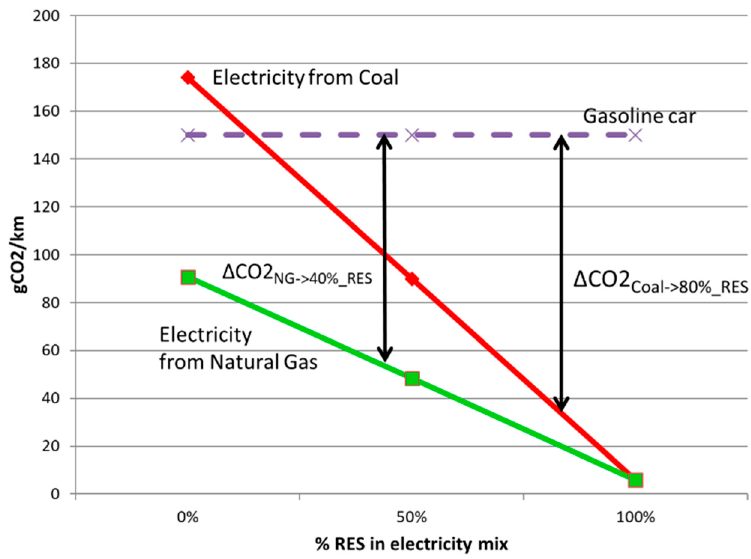
Figure 18. Specific WTW-CO 2 -emissions of fuels (excl. LCA emissions of the vehicle) in dependence of the share of RES in the electricity generation portfolio (based on [93]).